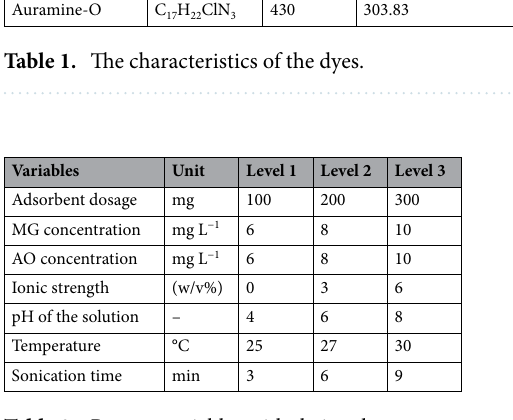
Table 2. Process variables with their